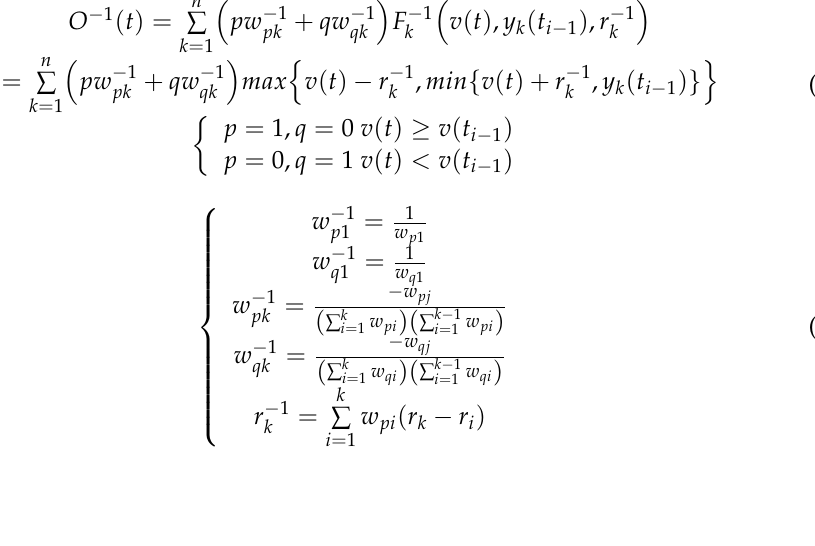
Figure 6. The inverted P ‐ I model.